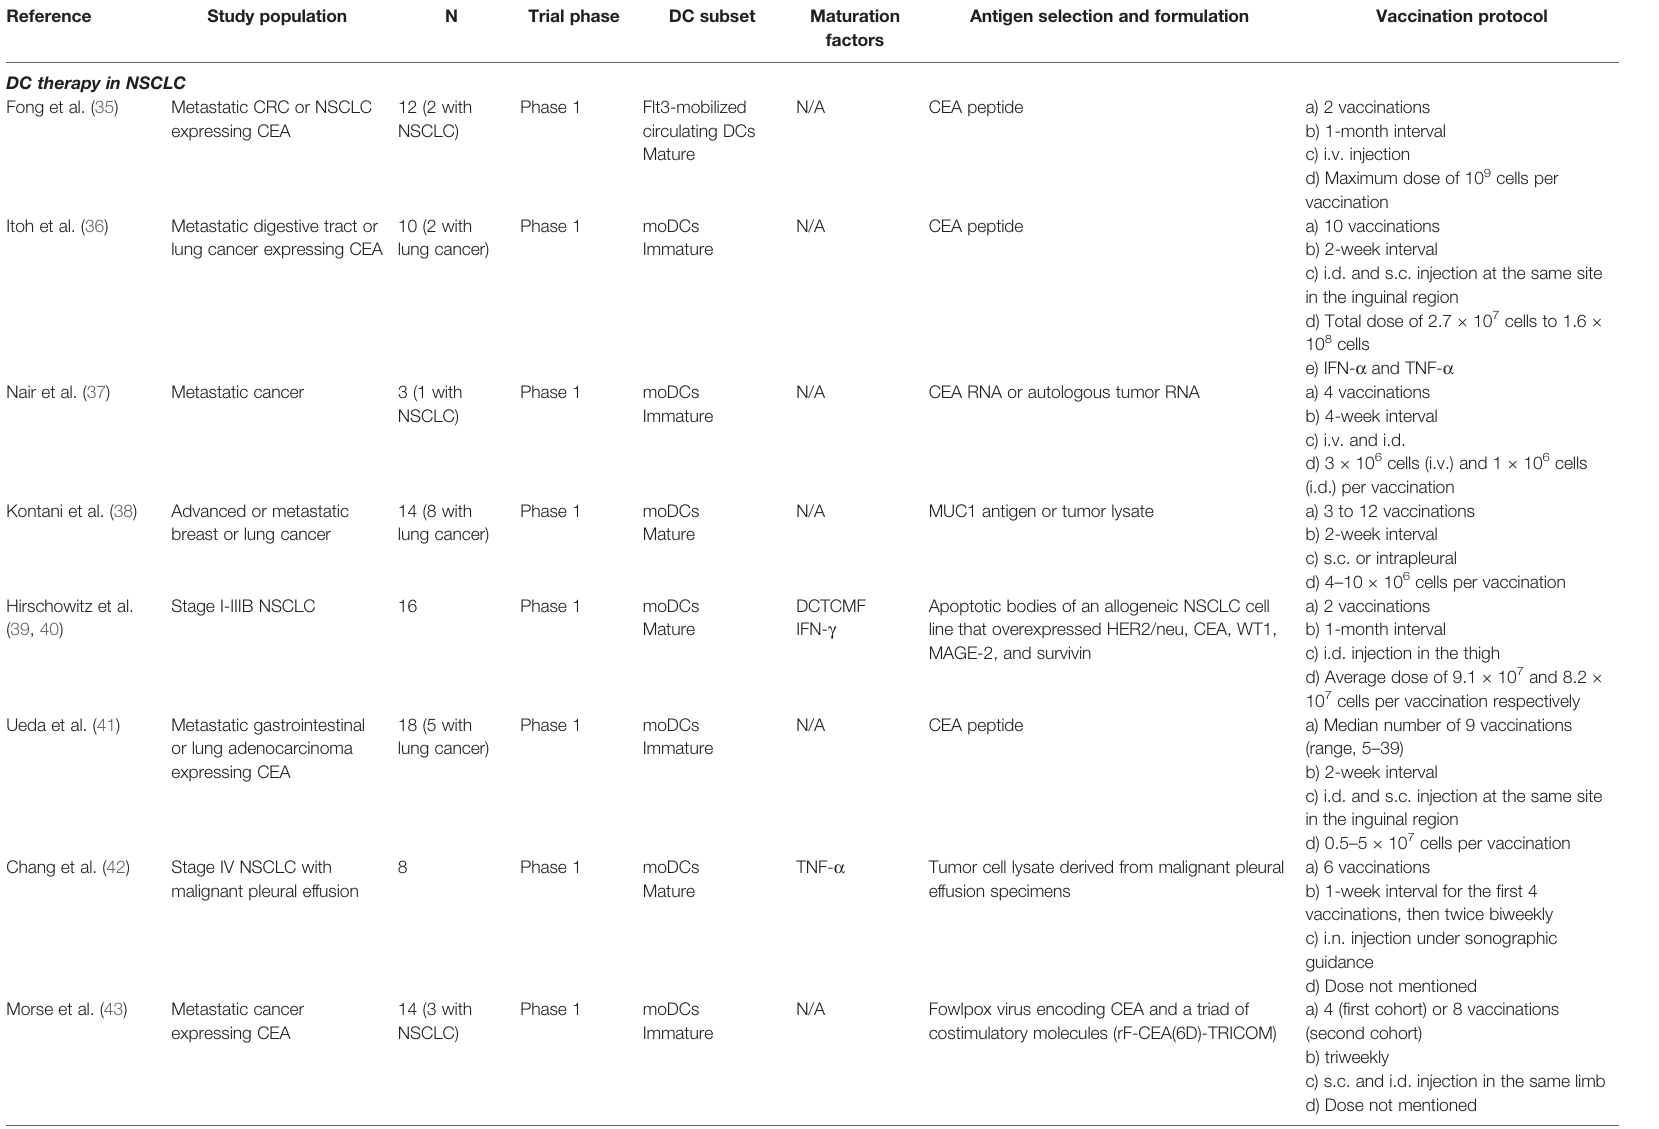
TABLE 1 | Overview of trials with dendritic cell (DC)-based immunotherapy in lung